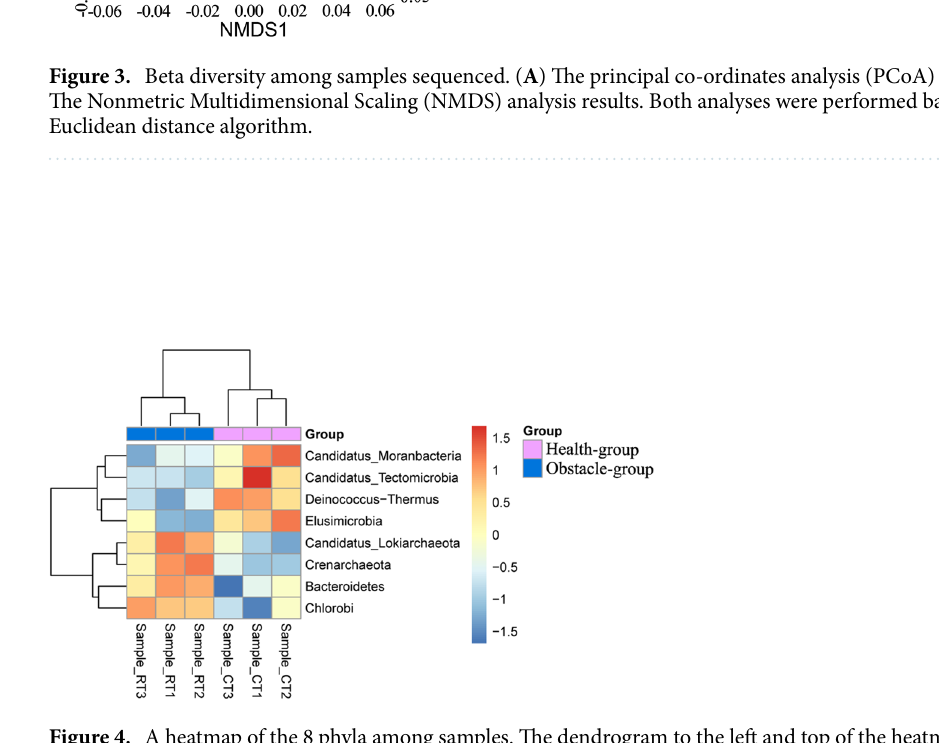
Figure 4. A heatmap of the 8 phyla among samples. The dendrogram to the left and top of the heatmap shows the clustering tree. The box was colored based on the standardized relative abundances data. The redder color shows a higher abundance of the phyla, and the blue color shows a lower